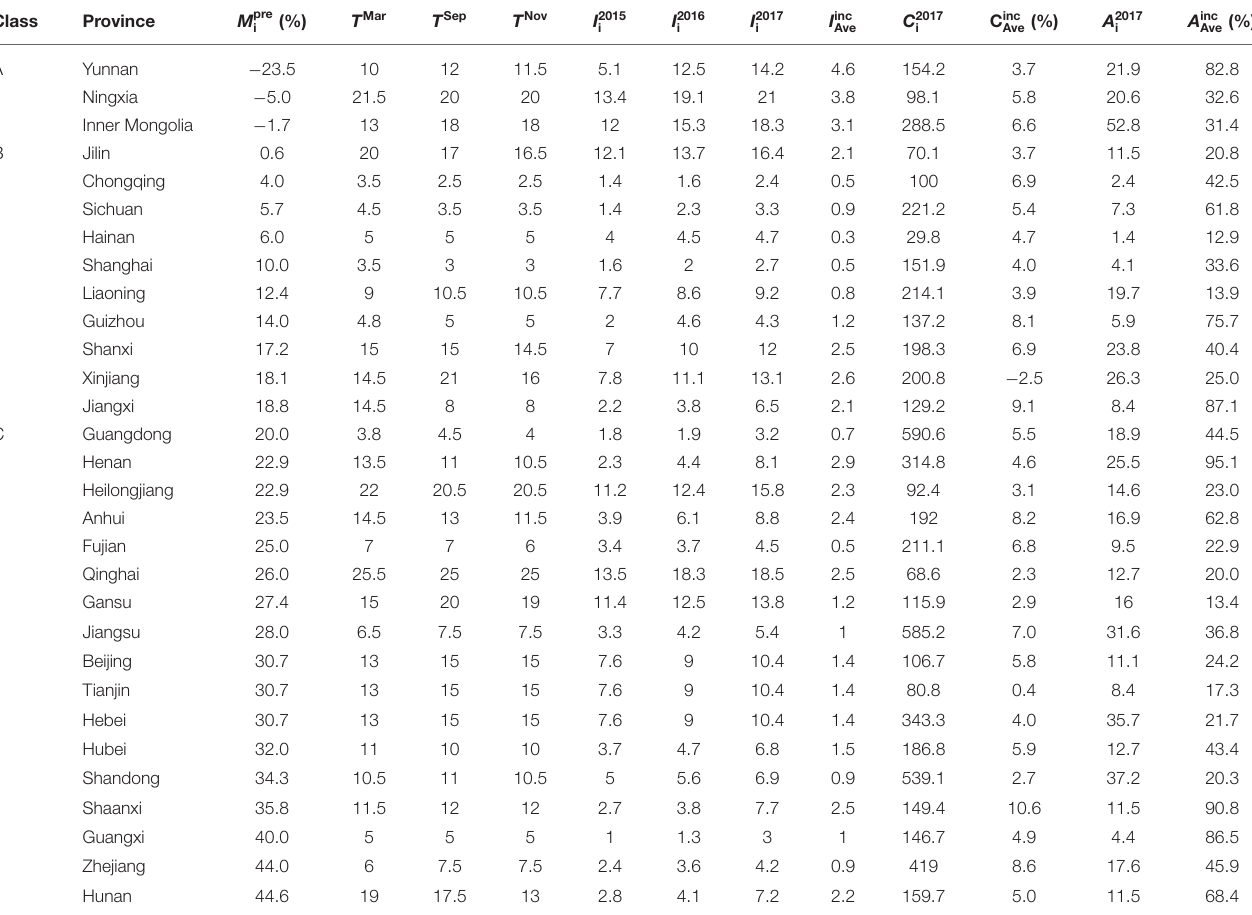
TABLE 1 | Evolution of the non-hydro RPS target and accommodation rate, 2015–2017 a . Class